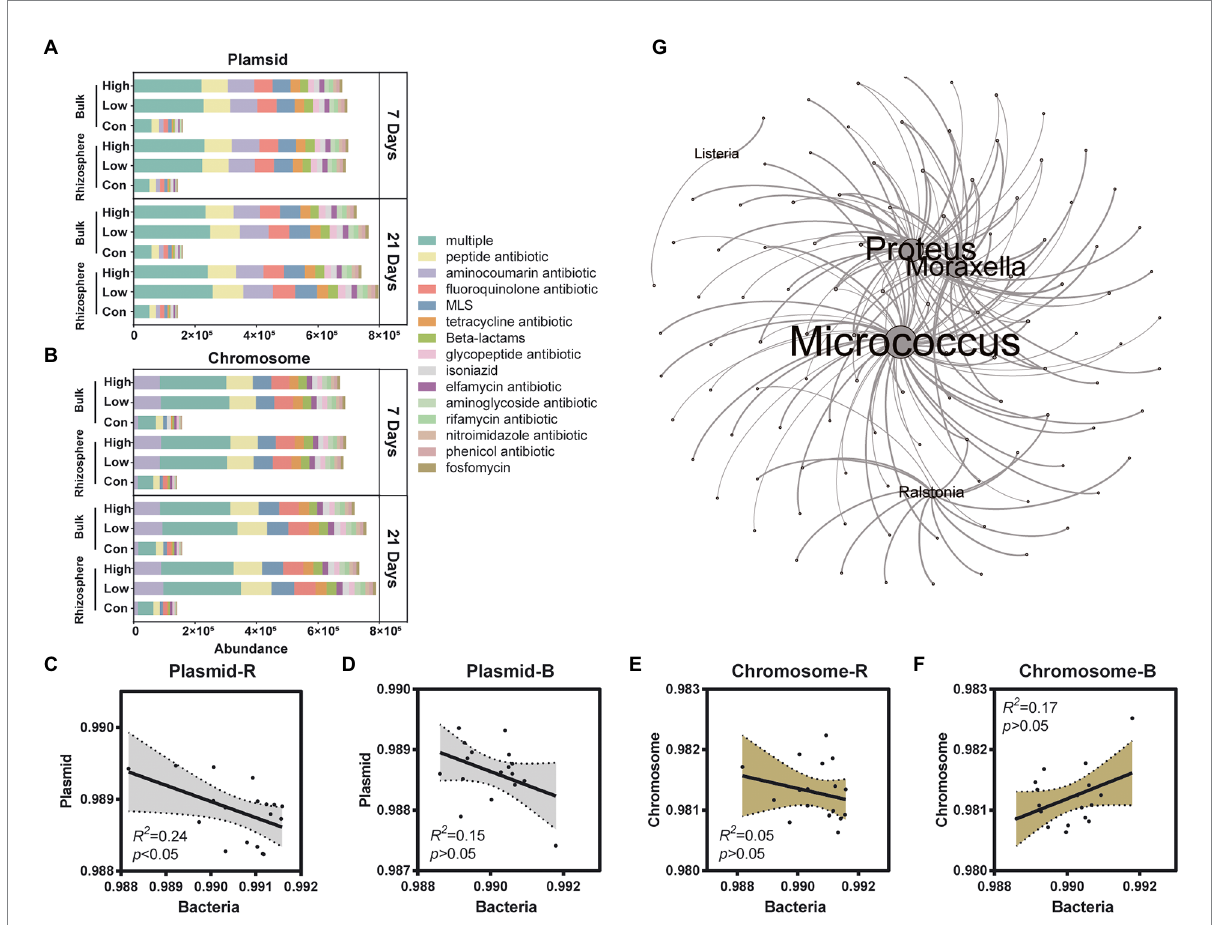
FIGURE 5 Effects of abamectin treatments on ARGs. (A,B) Compositions of ARGs in plasmids and chromosomes, respectively. Only ARG types detected in all samples are shown. (C–F) Liner regression analysis of the relative abundance of bacteria and ARGs carried by plasmid or chromosome. Dotted line shows 95% confidence intervals. (G) The co-occurrence of pathogens and AGRs, the size of nodes represented the correlation coefficient of pathogens and